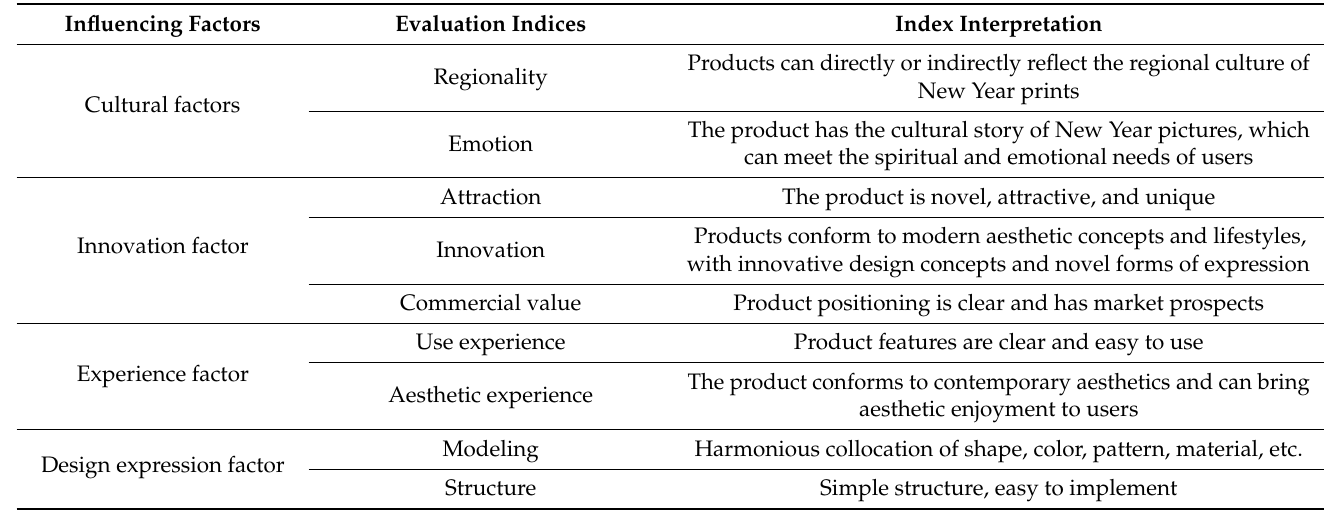
Table 3. The 4 influencing factors, 9 evaluation indices, and their interpretations.